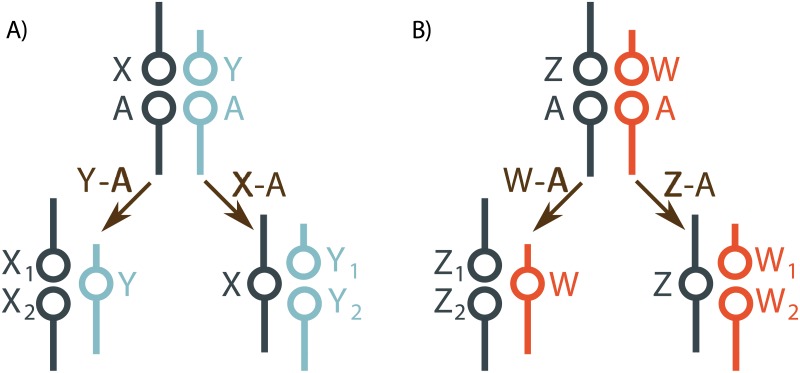
Sex chromosome-autosome fusions create multiple sex chromosome systems.(A) In XY systems, X-autosome (X-A) and Y-autosome fusions (Y-A) make XY1Y2 and X1X2Y systems, respectively. (B) In ZW systems, Z-autosome (Z-A) and W-autosome fusions (W-A) make ZW1W2 and Z1Z2W systems, respectively.